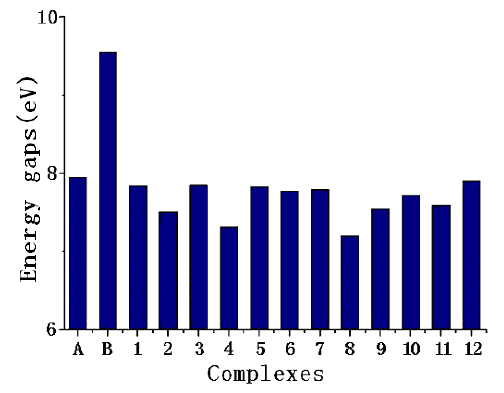
Fig. 2 LUMO-HOMO energy gaps of monomers A, B and complexes 1 to